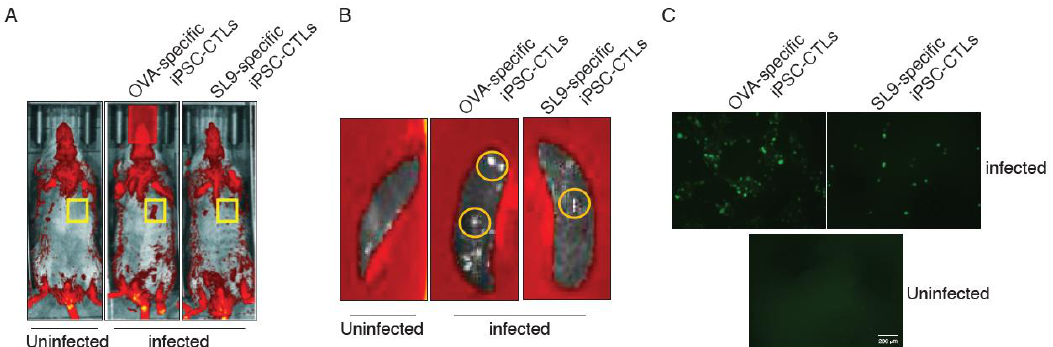
Figure 4. Adoptive transfer of SL9-specific iPSC-CTLs suppress EcoHIV infection in the spleens. HHD mice were i.v. adoptively transferred with SL9 or OVA 257–264 -specific DsRed + CD8 + pre-iPSC-CTLs and in the following week were i.p. infected with EcoHIV. Three weeks after EcoHIV infection, EcoHIV infection was analyzed. ( A ) Mice were monitored under the Lumina system. EcoHIV GFP fluorescence (yellow squares) was visualized. ( B ) Spleens were monitored under the Lumina system. EcoHIV GFP fluorescence (yellow cycles) was visualized. ( C ) Peritoneal macrophages were detected expression of GFP under a confocal microscope. All data are representative of five mice per group of three independent experiments.